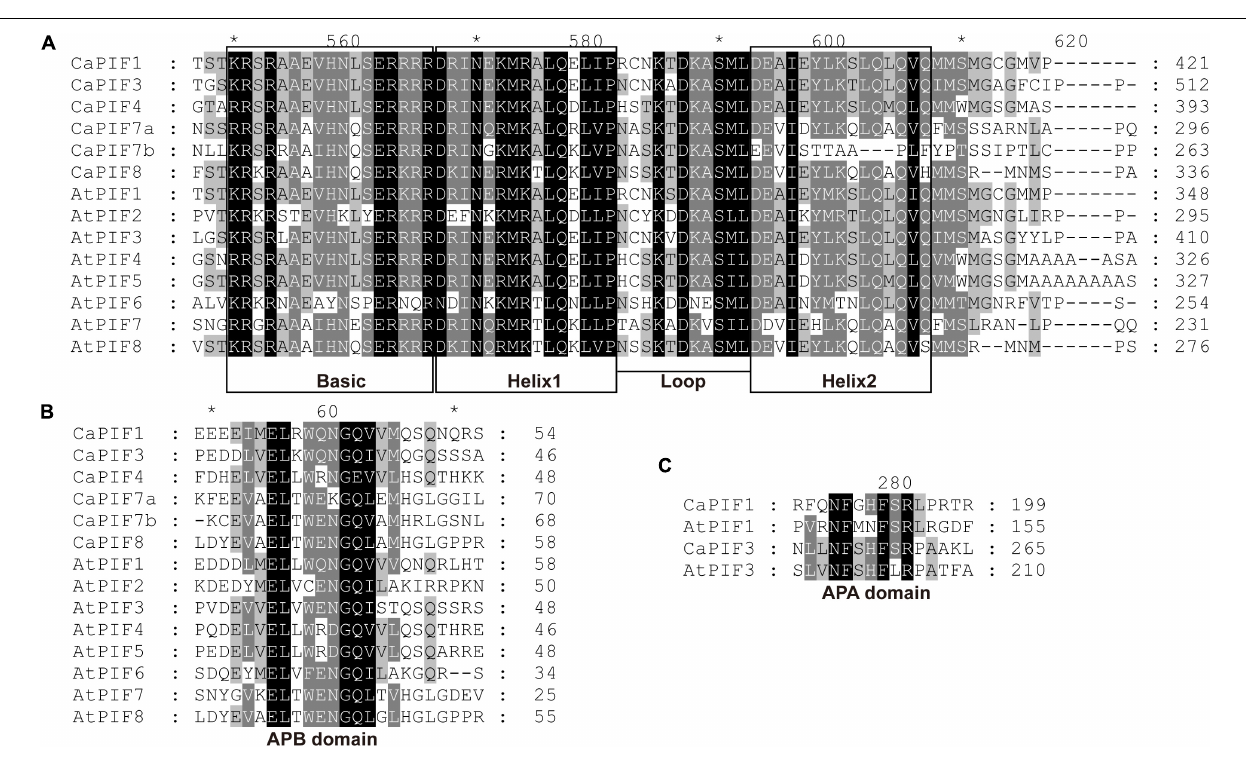
FIGURE 1 | Multiple sequence alignment of the conserved bHLH (A) , APB (B) , and APA (C) domains of PIFs from pepper and Arabidopsis . Multiple sequence alignment was performed with Clustal Omega and displayed with the GeneDoc software. Asterisks were automatically generated by the GeneDoc